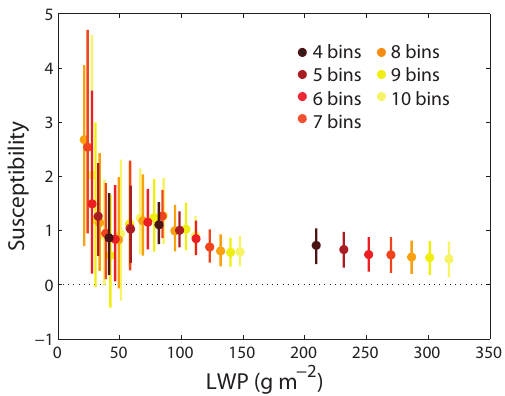
Fig. 8. The precipitation susceptibility is calculated in equally weighted cloud liquid water path (LWP) bins when the data are av- eraged over 5km segments. Different shades denote the number of bins.